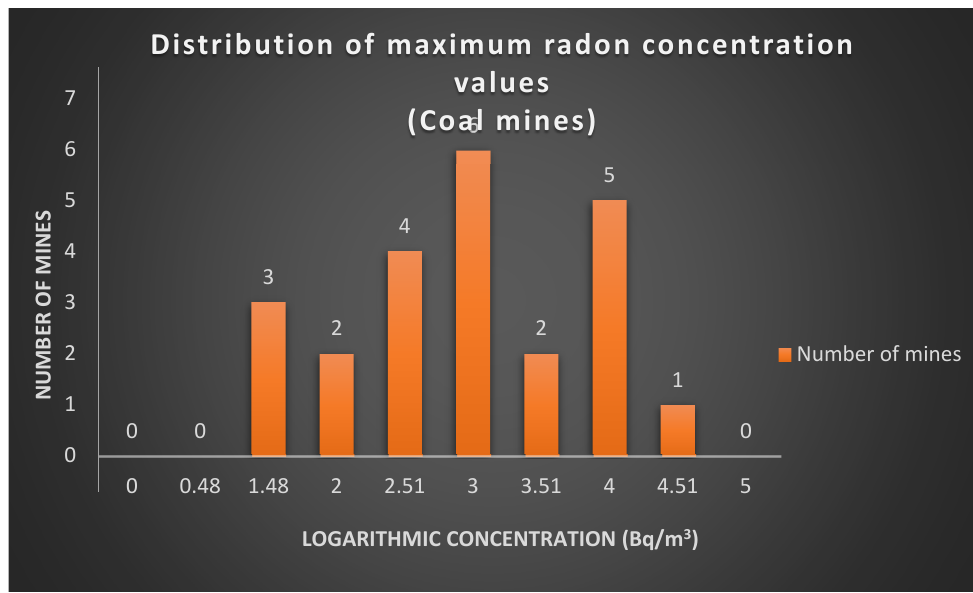
Figure 2 . Distribution of radon concentration in coal mines . Figure 2. Distribution of radon concentration in coal mines.